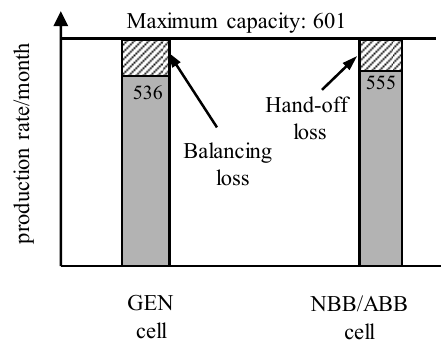
Figure 6. Performance of assembly methods under deterministic task time.